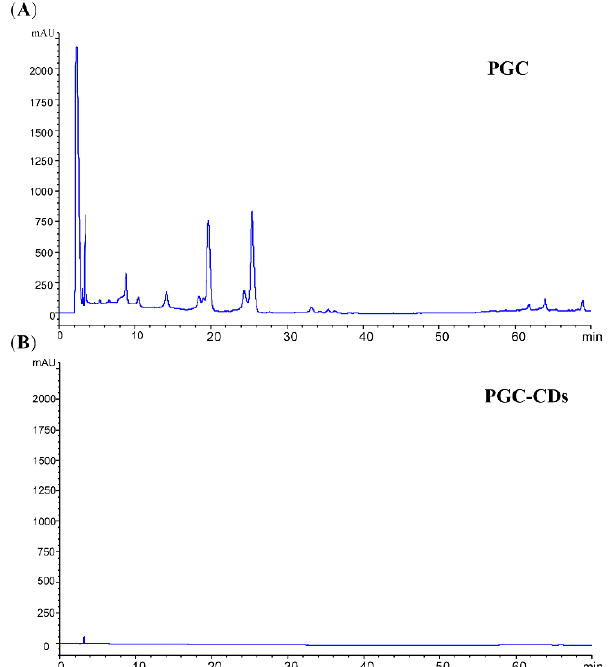
Figure 3. High - performance liquid chromatogram of PGC ( A ) and PGC - CDs ( B ) aqueous solution. Figure 3. High-performance liquid chromatogram of PGC ( A ) and PGC-CDs ( B ) aqueous